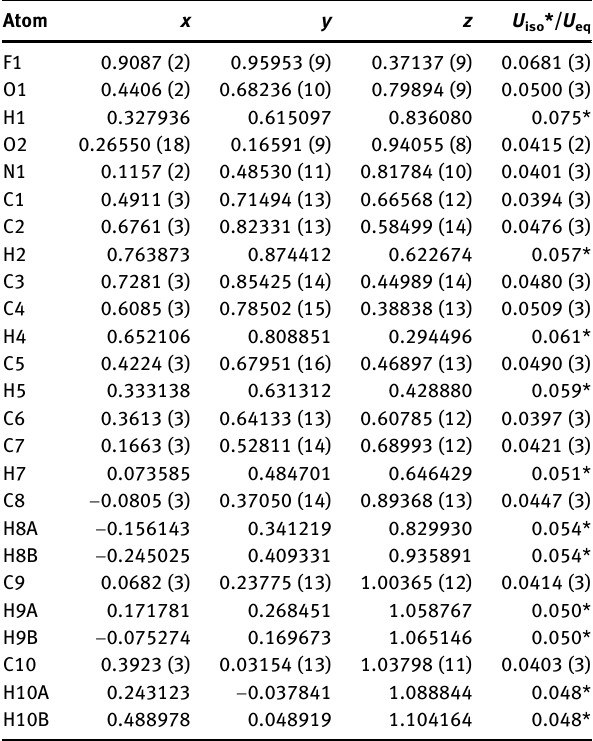
Table  : Fractional atomic coordinates and isotropic or equivalent isotropic displacement parameters (Å 